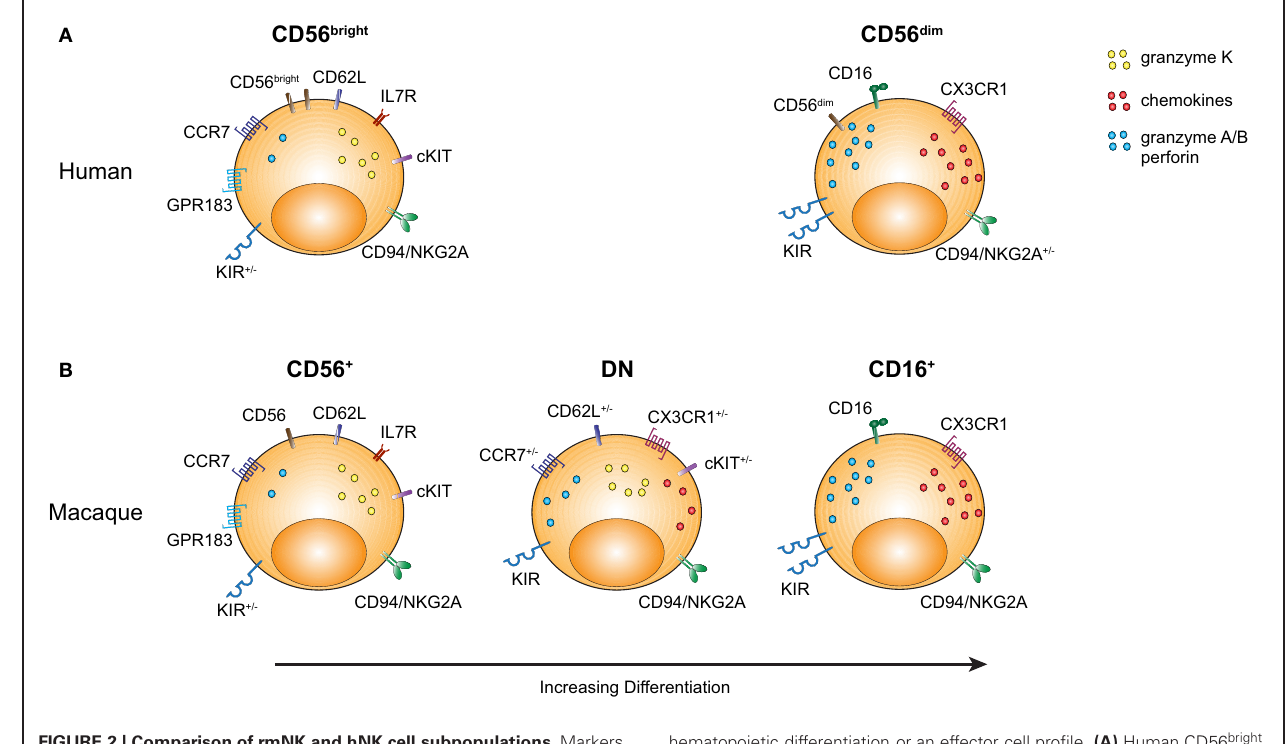
FIGURE 2 | Comparison of rmNK and hNK cell subpopulations. Markers characterizing the distinct NK cell subpopulations are illustrated with an emphasis on molecules either indicating a more primitive stage of